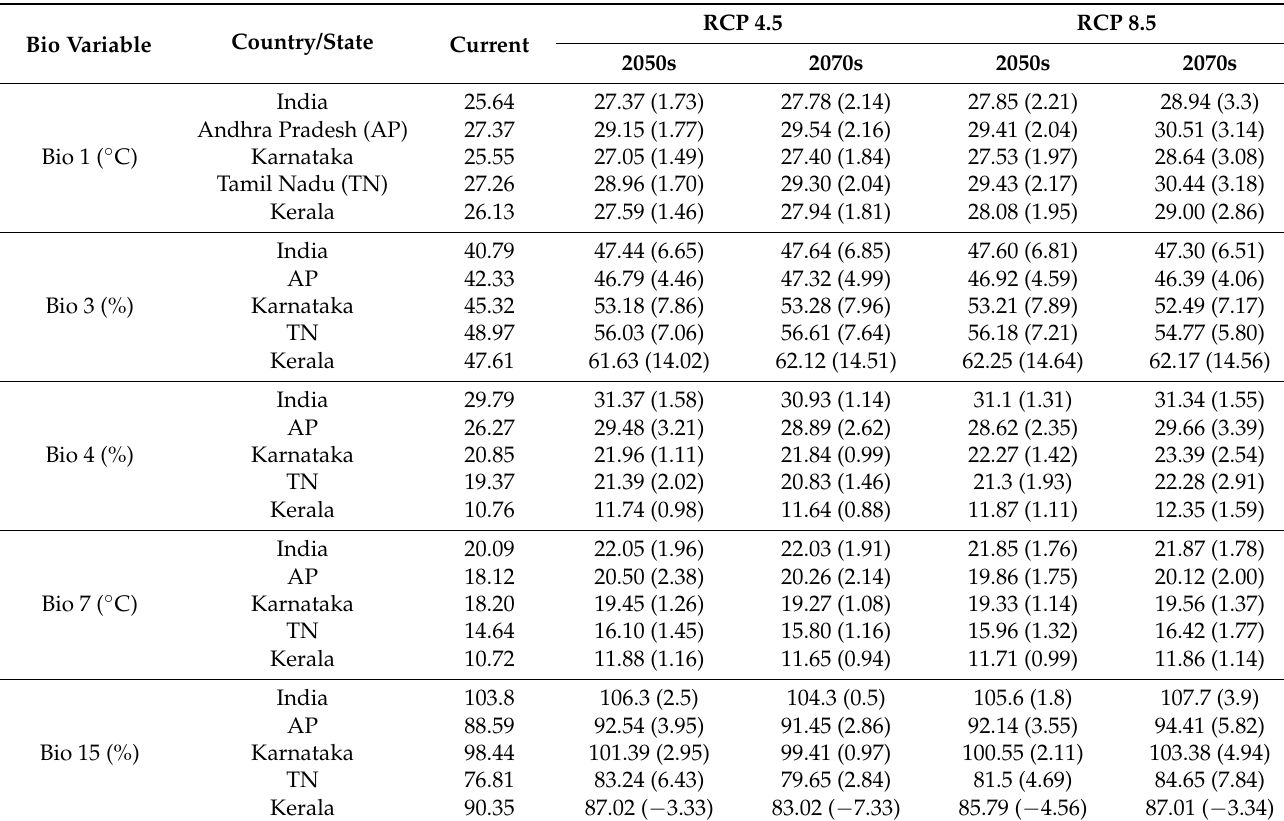
Table 5. Annual mean temperature (Bio 1), Isothermality (Bio 3), Temperature Seasonality (Bio 4), Temperature Annual Range (Bio 7), and Precipitation Seasonality (Bio 15) for the current and future scenarios of the 2050s and 2070s under RCP 4.5 and RCP 8.5 of India and major coconut growing states. The values in brackets indicate change from the current